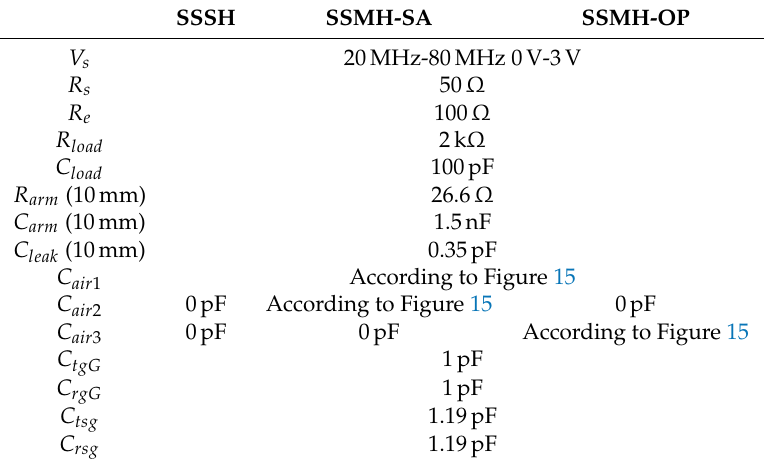
Figure 15. Relationship between C air and distance of two ground electrodes with different areas in CST. Table 3. Parameters of the Proposed Empirical Circuit